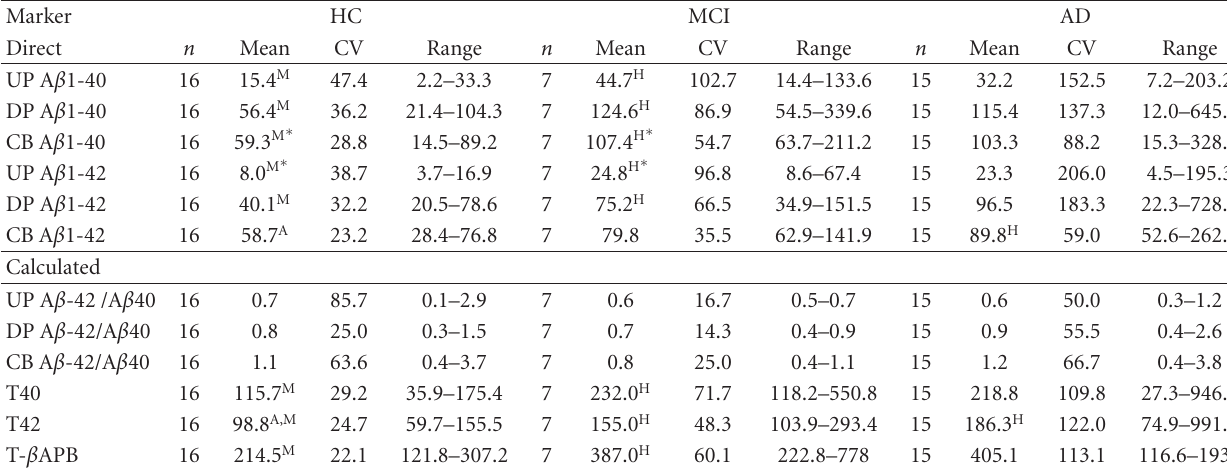
Table 2: Levels of direct and calculated markers in each group of participants.